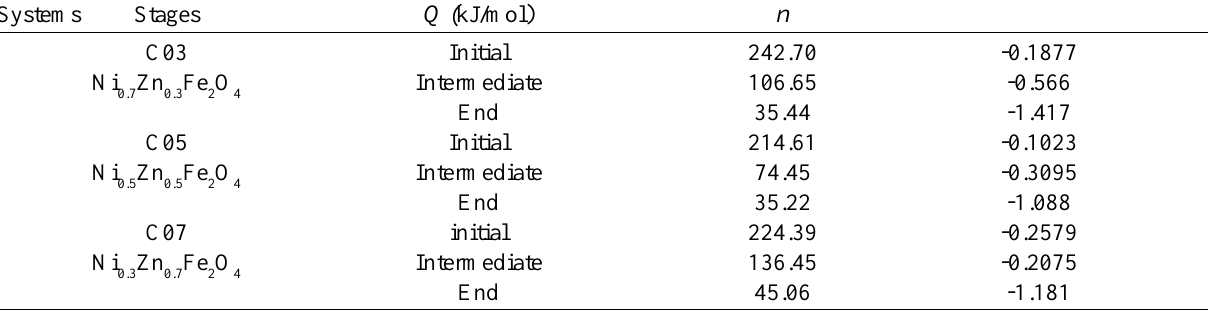
Table 3. Sintering parameters with a constant heating rate (CHR) of 5 °C/min for C03, C05 and C07 sintered at 1200 °C; Q = activation energy, n = sintering